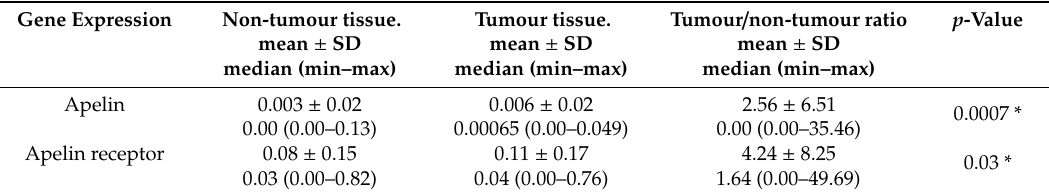
Table 2. Apelin and apelin receptor mRNA expression levels in CRC patients. Gene expression was normalized to glyceraldehyde 3-phosphate dehydrogenase (GAPDH) and compared to non-tumor tissue using the Wilcoxon test. * Statistically significant at p <